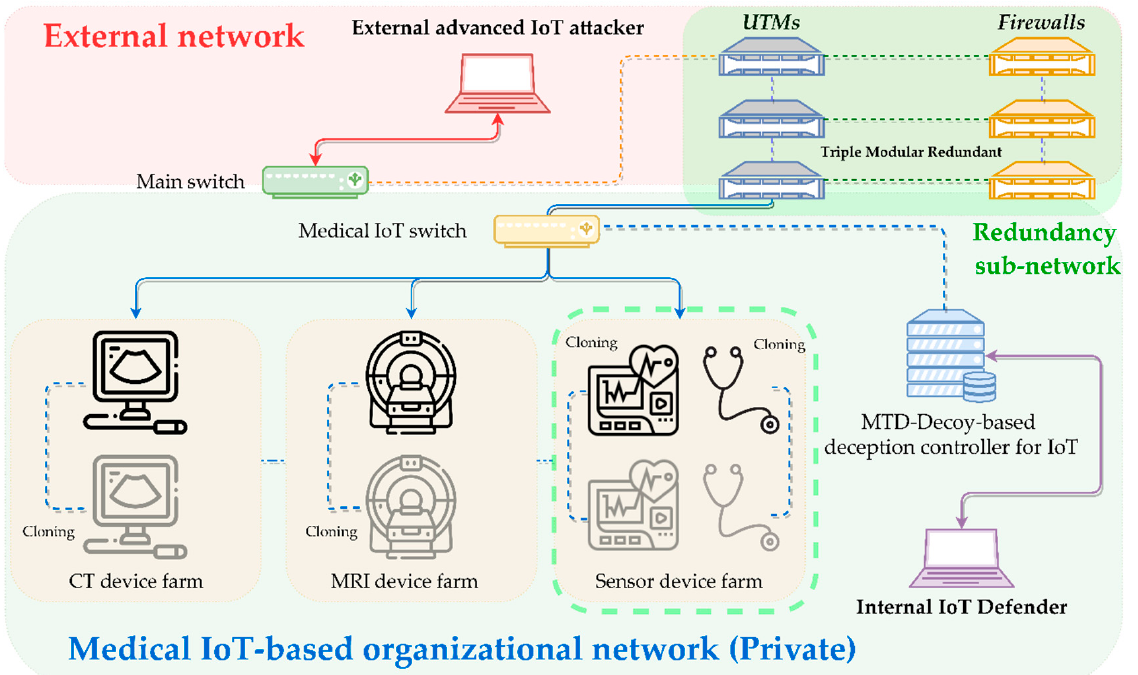
Figure 6. Overview of the medical IoT-enabled topology with an organizational attack–defense strategy for Scenario 3.